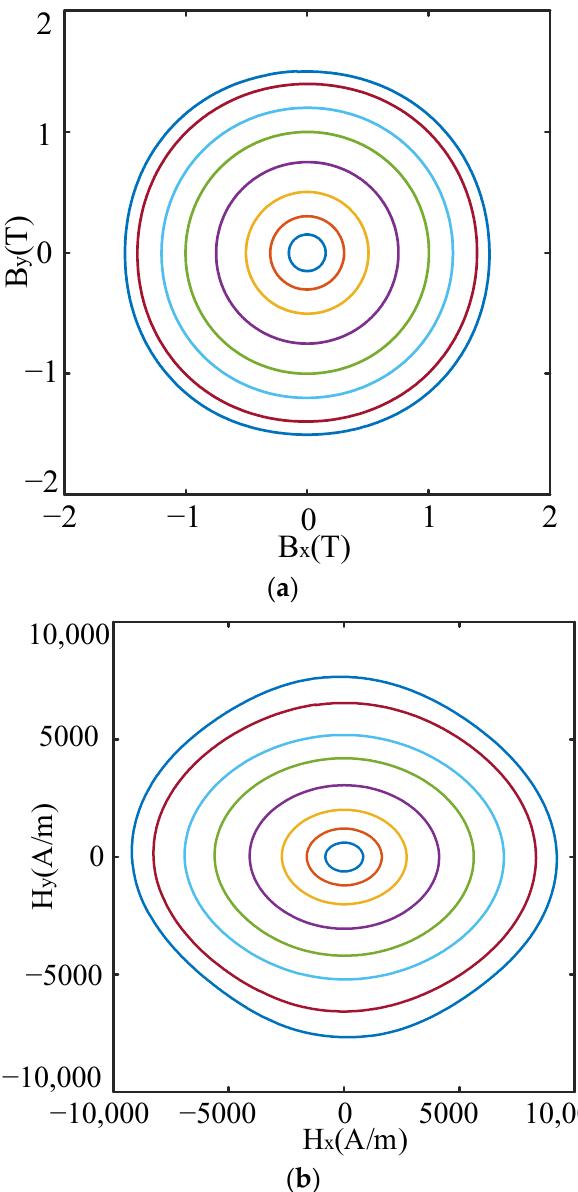
Figure 5. 2D measurement of ZY 1k101 at 50 Hz: ( a ) B loci with various magnetic flux densities, ( b ) corresponding H loci.